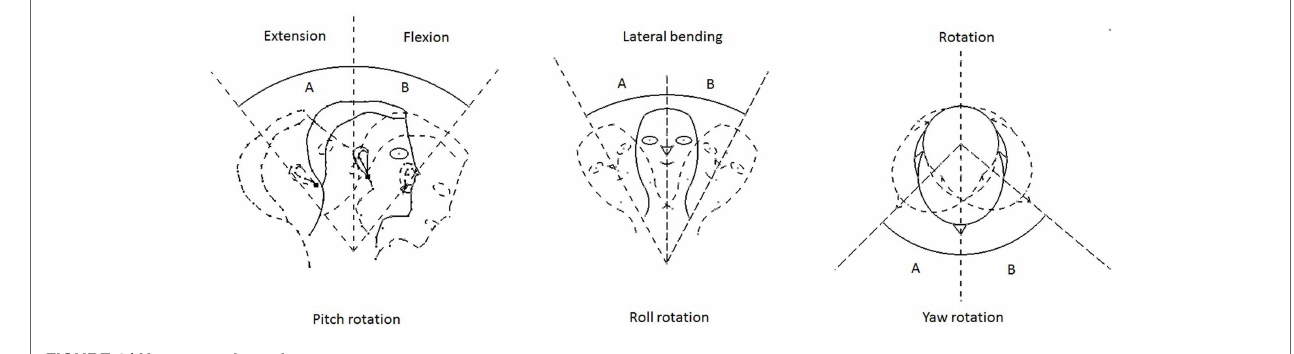
FIGURE 1 | Human neck motions .